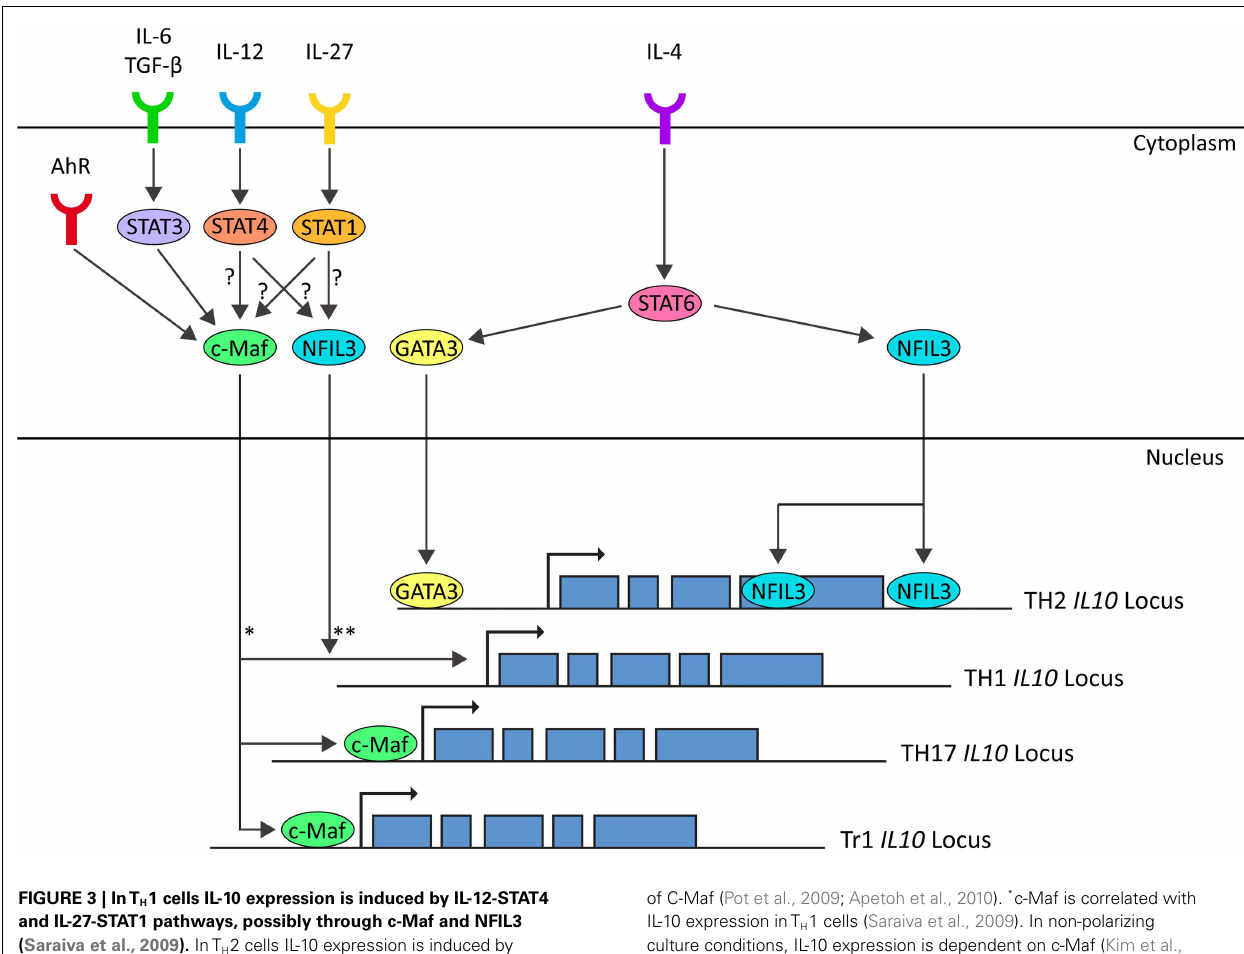
FIGURE 3 | InT H 1 cells IL-10 expression is induced by IL-12-STAT4 and IL-27-STAT1 pathways, possibly through c-Maf and NFIL3 (Saraiva et al., 2009). InT H 2 cells IL-10 expression is induced by IL-4-STAT6 through GATA3 (imprinting and chromatin modification) and NFIL3 (Shoemaker et al., 2006; Motomura et al., 2011). InT H 17 cells IL-10 expression is induced by IL-6/TGF- β -STAT3 through c-Maf (Xu et al., 2009). InTr1 cells, IL-10 is induced by IL-27 and AhR through induction